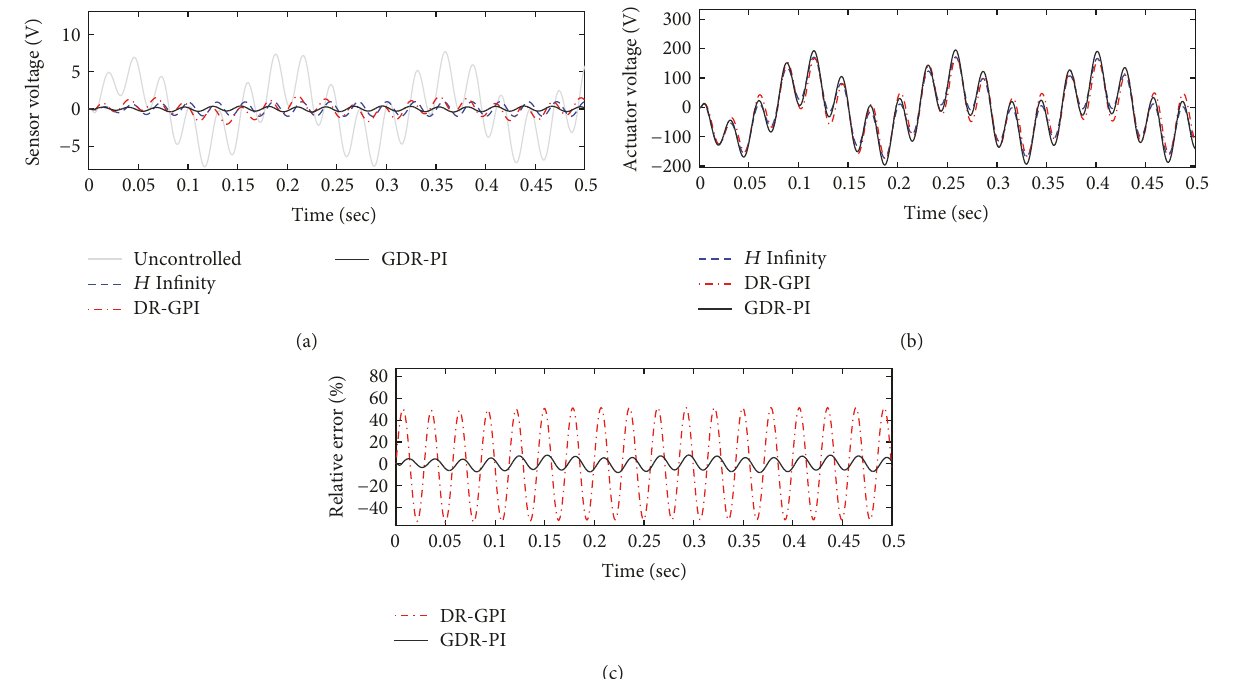
Figure 9: The time domain response of the controlled and uncontrolled smart beam under a harmonic disturbance with the second eigenfrequency (assumed as unknown): (a) sensor output, (b) control input, and (c) relative error of estimated disturbance.